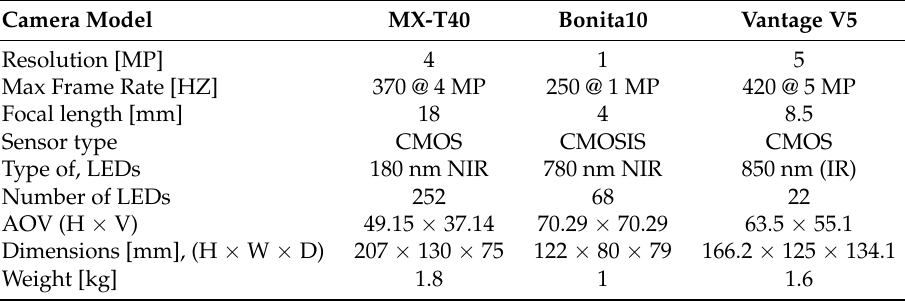
Table 2. Vicon camera